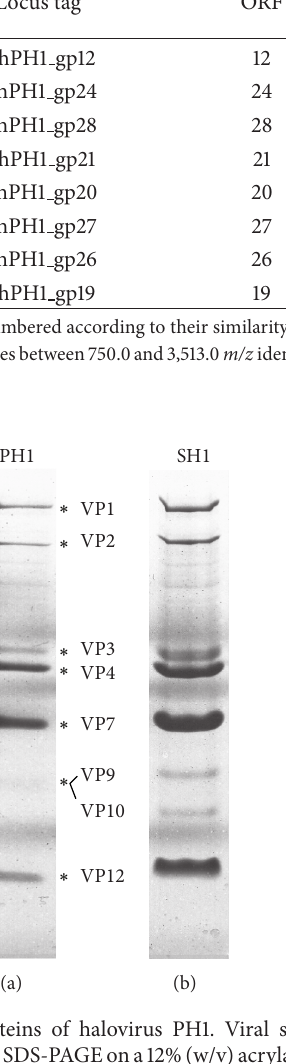
Table 2: PH1 virus proteins identified by mass spectroscopy of tryptic peptides. Protein a